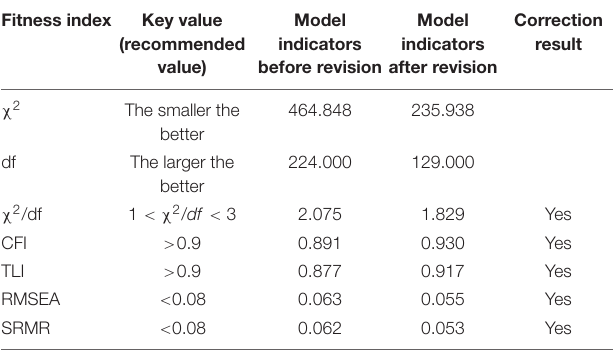
TABLE 2 | Analysis of the degree of fitting of the model.